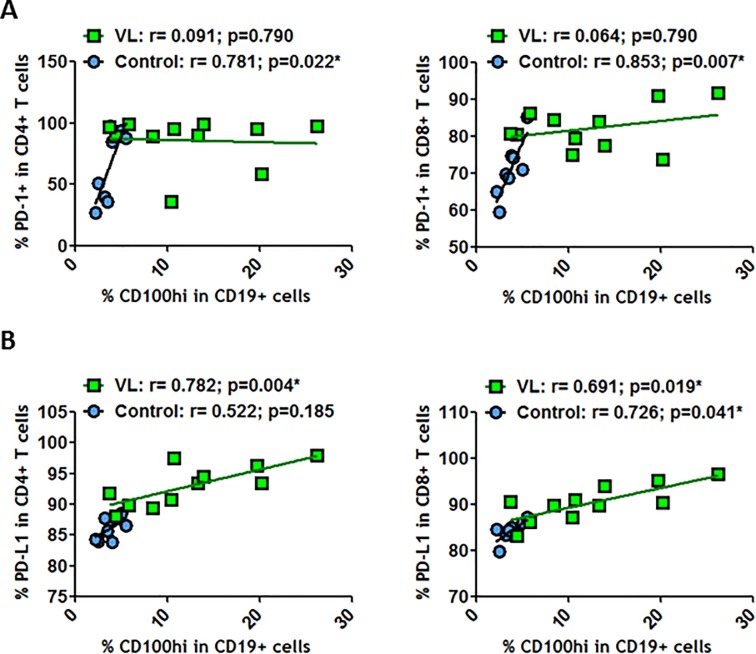
Correlations between CD100hi on CD19+ cells and PD-1 and PD-L1 on T cells.(A) Correlations between frequencies of CD100hi on CD19+ cells and frequencies of PD-1 on CD4+ T cells and on CD8+ T cells. (B) Correlations between frequencies of CD100hi on CD19+ cells and frequencies of PD-L1 on CD4+ T cells and on CD8+ T cells. Correlations were determined by Spearman’s rank correlation. * = p<0.05 when comparing conditions. Each symbol corresponds to an individual.